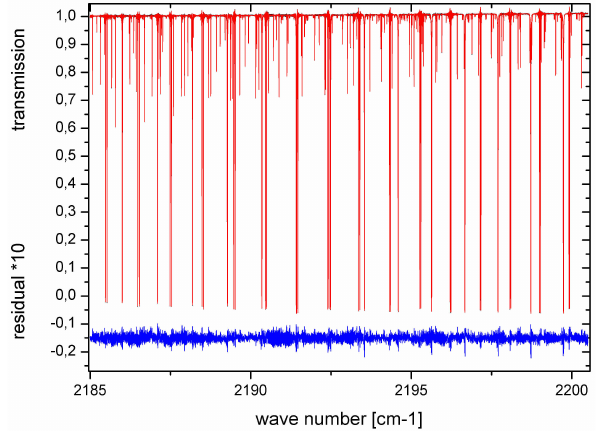
Fig. 7. The averaging kernels of the ILS retrieval for the N 2 O cell spectrum shown in Fig. 5 (the modulation amplitude kernels are shown). A comparison with Fig. 3 reveals the improved sensitivity of the retrieval for small